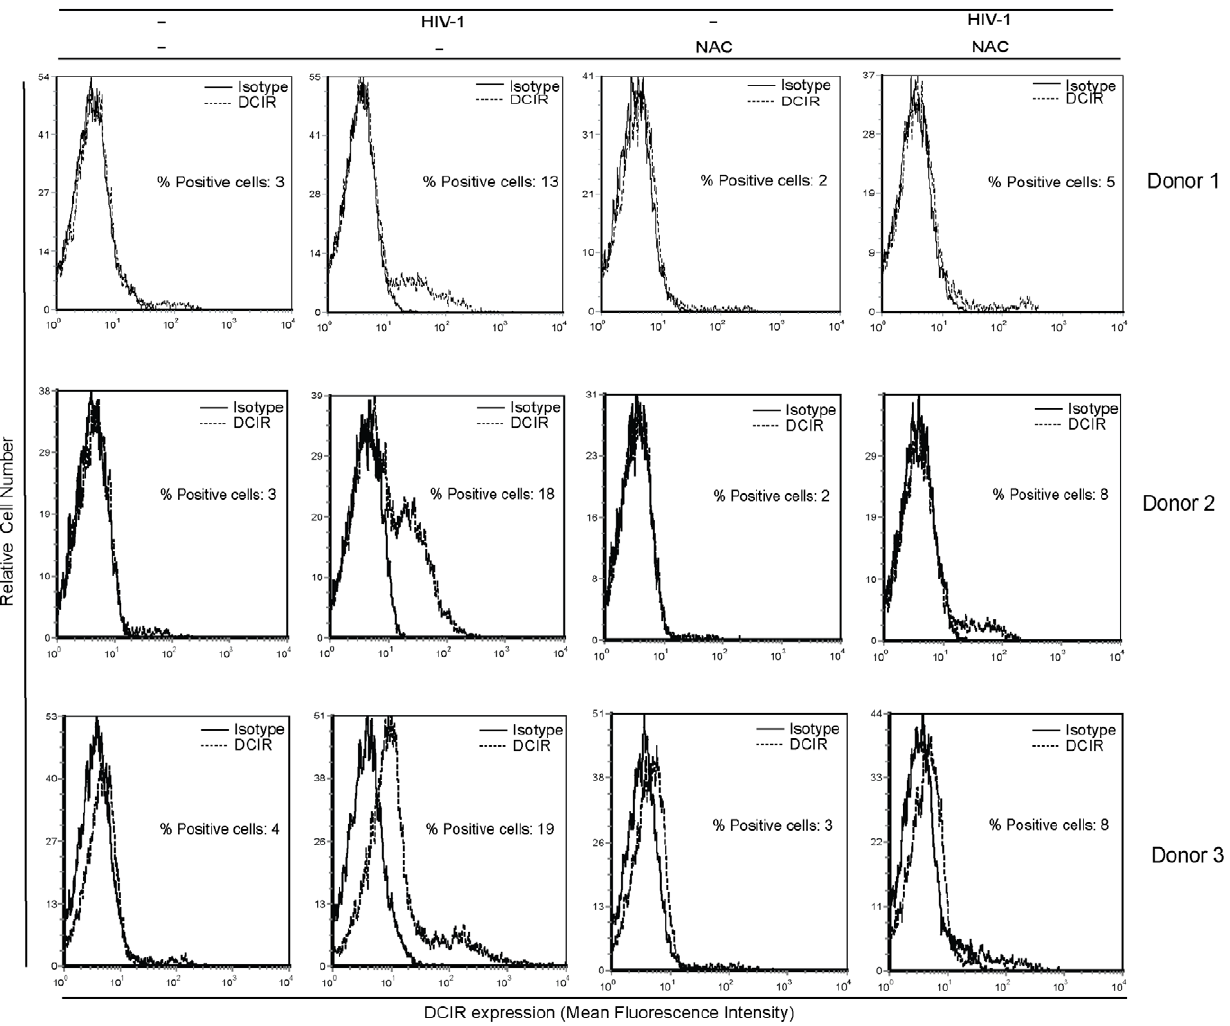
Figure 5. HIV-1-dependent DCIR induction is due also to a caspase-independent process involving AIF. Cells (1 6 10 6 ) were first either left untreated or treated for 1 h with NAC, after which HIV-1 (100 ng of p24) was added. DCIR expression was monitored 3 days later by flow cytometry. Expression of DCIR is shown as a dotted line, whereas the continuous line represents staining obtained with an isotype-matched irrelevant control Ab. Data shown correspond to 3 independent experiments performed with distinct healthy